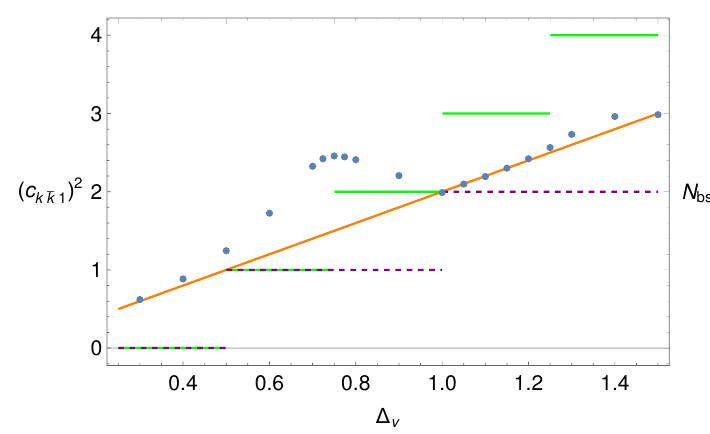
Figure 20 . The blue points represent the upper bound on the kink anti-kink Z 2 odd breather OPE coefficient as a function of the kink dimension ∆ v , assuming a Z 2 odd bound state of dimension 1, a Z 2 even bound state of dimension 2, and all gaps to be 2∆ v . In orange we plot the analytic result for the winding mode correlator. Finally in green and purple, we plot the number of bound states in the IR and UV sine-Gordon theories, respectively.